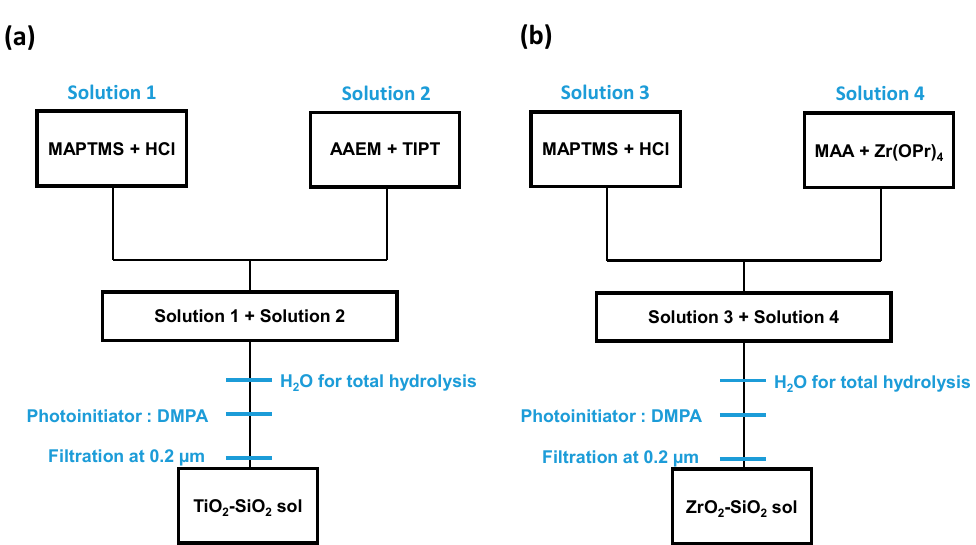
Figure 2. Preparation of the different organic–inorganic sol–gel solutions. Material synthesis of ( a ) TiO 2 –SiO 2 and ( b ) ZrO 2 –SiO 2 sols. In both cases, a photoinitiator (DMPA) is added to induce the start of UV-polymerization reactions.